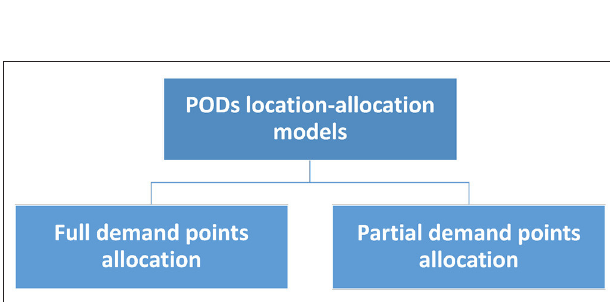
FIGURE 3 | Taxonomy of PODs location-allocation models during public health